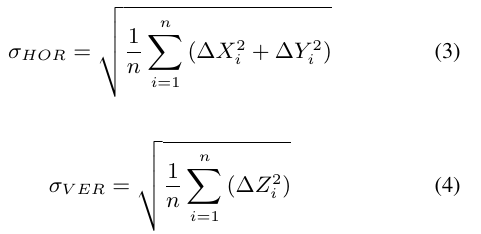
Figure 5: VICON camera (left) and CATEC indoor testbed (right) optimized implementation of the algorithms described above. Fi- nally, accuracy is calculated as the distance between the real point and the matched point in the 3D model. Complete flowchart is shown in Figure 4.